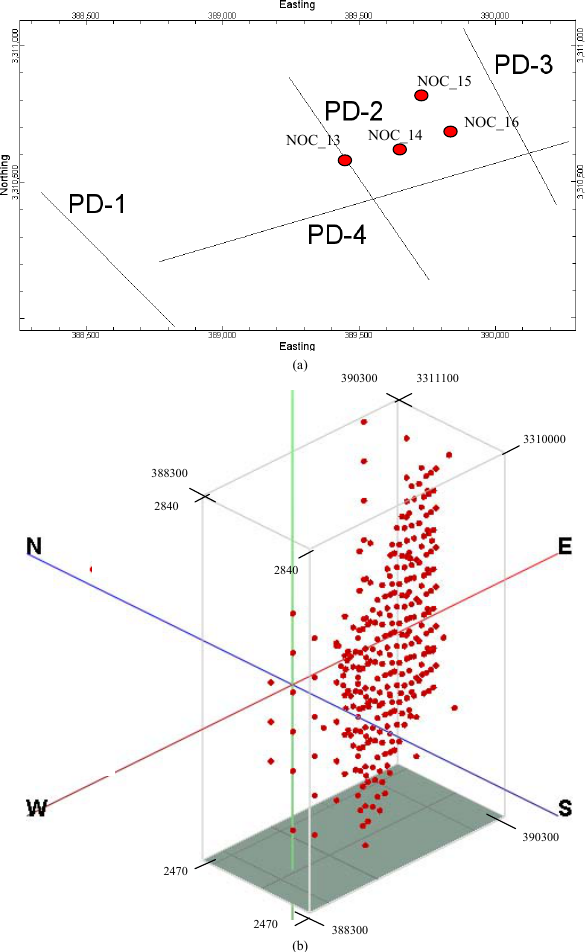
Fig. 2. a) Location of geoelectrical profiles and location map of mineralized boreholes in the study area and b) spatial distribution Fig. 2. (a) Location of geoelectrical profiles and location map of of collected geoelectrical data in Nowchun deposit (red dots are surveyed points for geoelectrical parameters consist of mineralized boreholes in the study area and (b) spatial distribution chargeability and electrical resistivity with vertical exaggeration of 8.34) of collected geoelectrical data in Nowchun deposit (red dots are sur- veyed points for geoelectrical parameters consist of chargeability and electrical resistivity with vertical exaggeration of